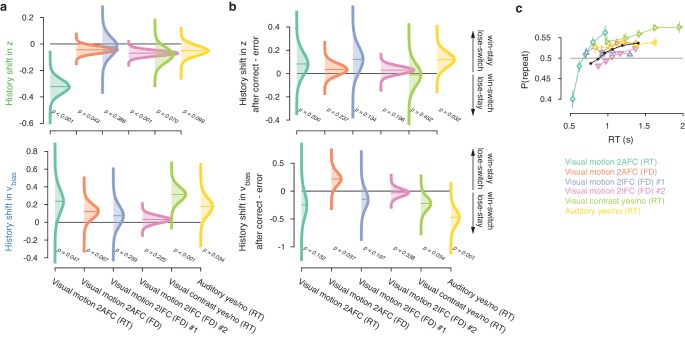
Group-level posterior distributions of history bias parameters.History shift in (a) starting point and drift bias, as well as the effect of previous choice outcome on (b) starting point and drift bias, separately for each dataset. The posteriors were taken from the model where history-dependent z and vbias were fit simultaneously. Distributions were smoothed using kernel density fits. Shaded regions represent the 95% BCI, and white lines indicate the posterior mean. p-Values indicate the overlap with zero (a), or between the two conditions (b). (c) Repetition probability for five quantiles of the RT distribution, separately for each dataset (colors) and averaged across datasets (black). For those RTs < 600 ms, group-level behavior tended towards choice alternation.